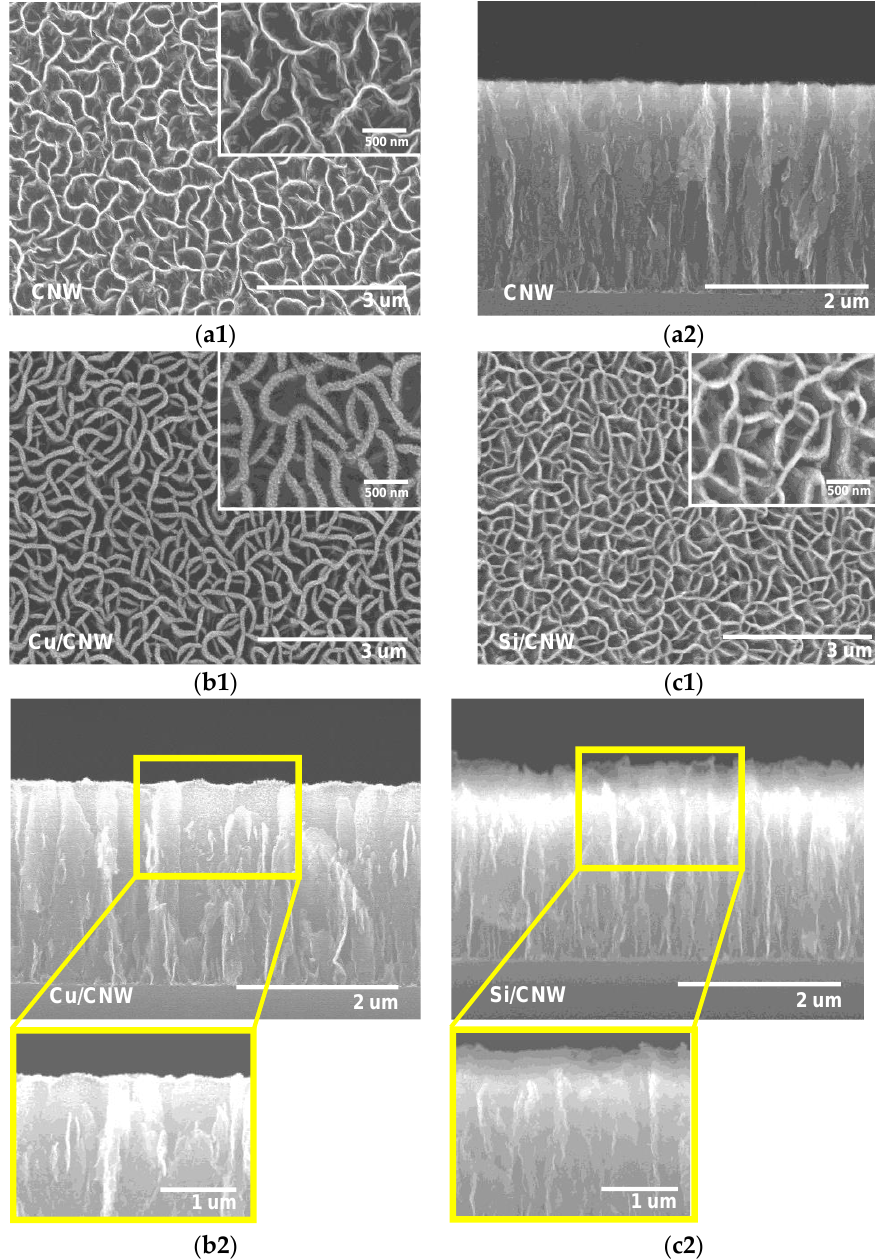
Figure 5. FE-SEM surface image of ( a1 ) CNW, ( b1 ) Cu − CNW, and ( c1 ) Si − CNW; and FE-SEM cross-section image of ( a2 ) CNW, ( b2 ) Cu − CNW, and ( c2 ) Si − CNW.